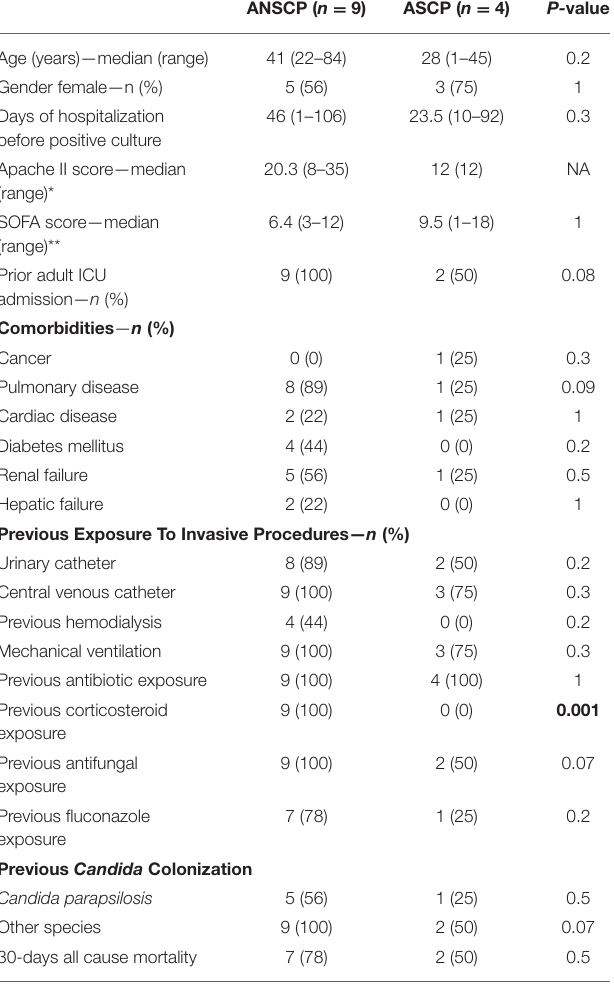
TABLE 3 | Epidemiological and clinical characteristics of HUMAP-UFMS patients with positive cultures for clonal azole non-susceptible (ANSCP) and azole-susceptible (ASCP) Candida parapsilosis